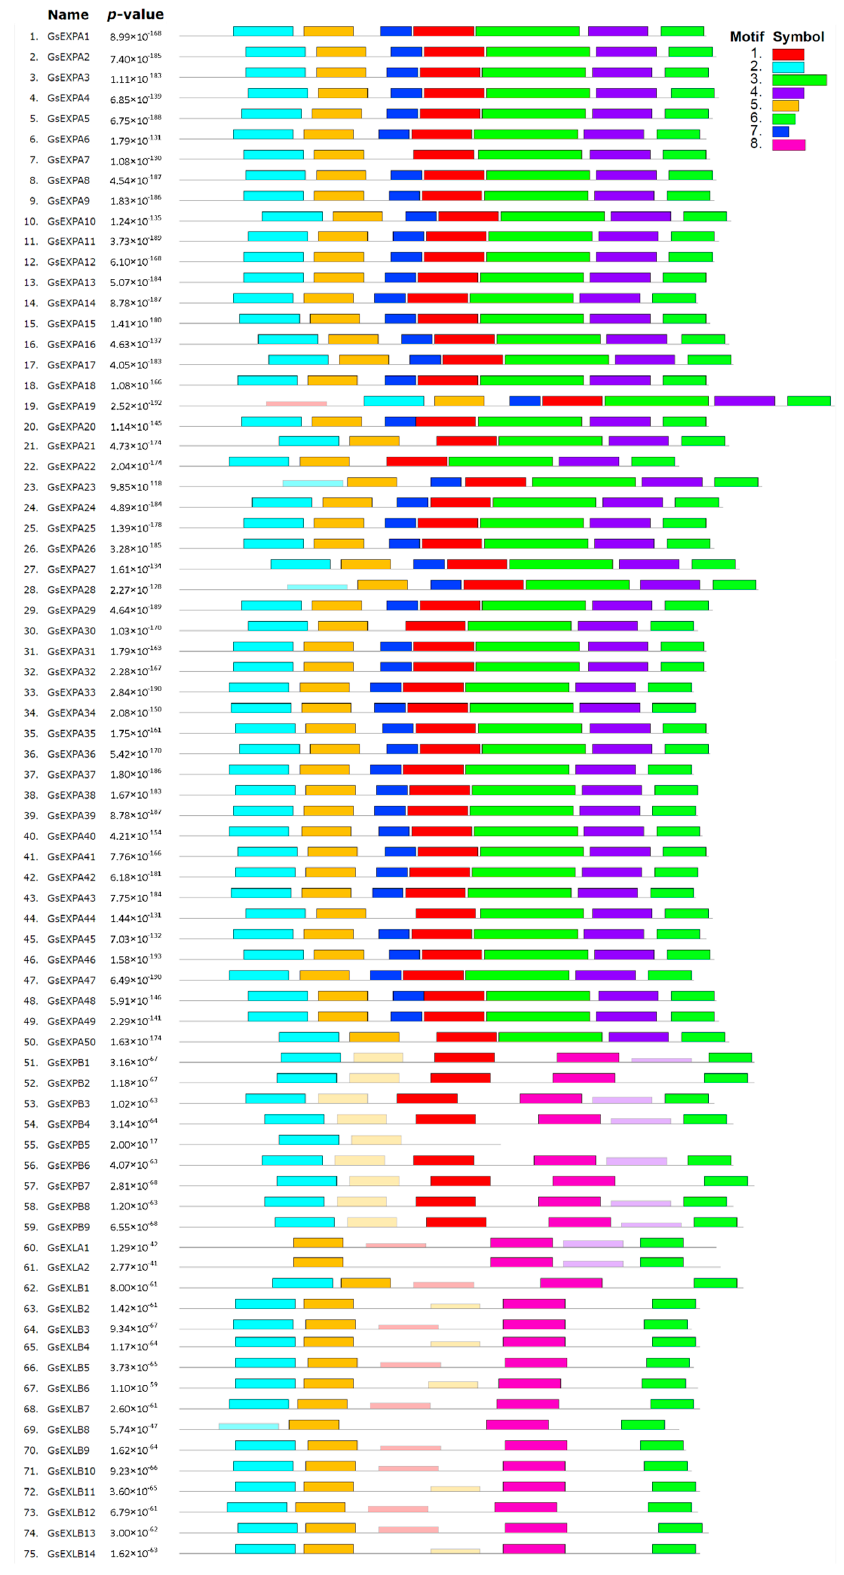
Figure 3. Analysis results of wild soybean expansins conserved motifs. p value, expected value for motif